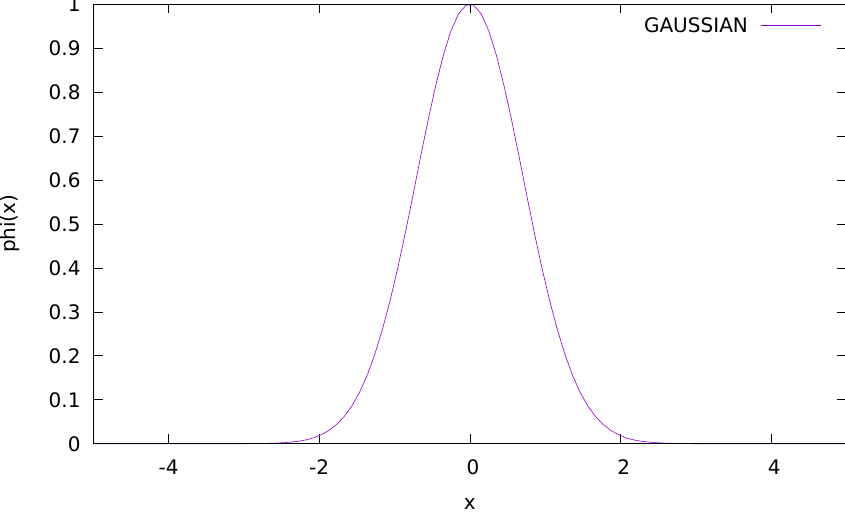
Figure 3. Typical plot of the Gaussian